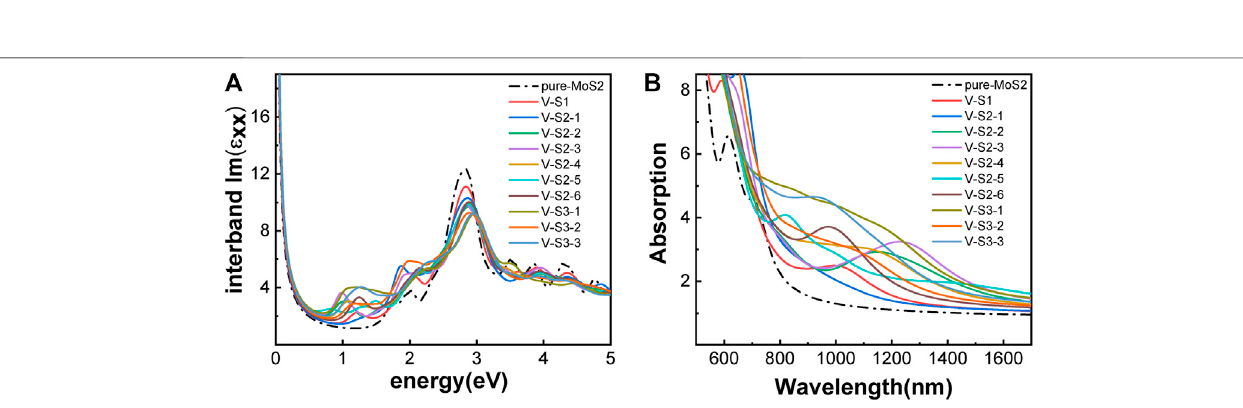
Frontiers in Chemistry |